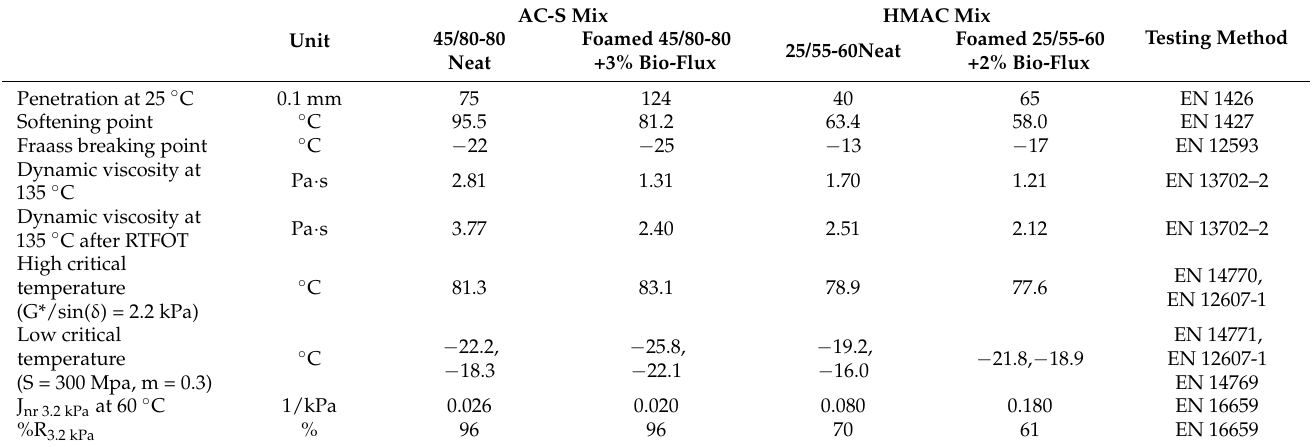
Table 4. Characterization of asphalt binders used for producing the investigated asphalt mixtures.